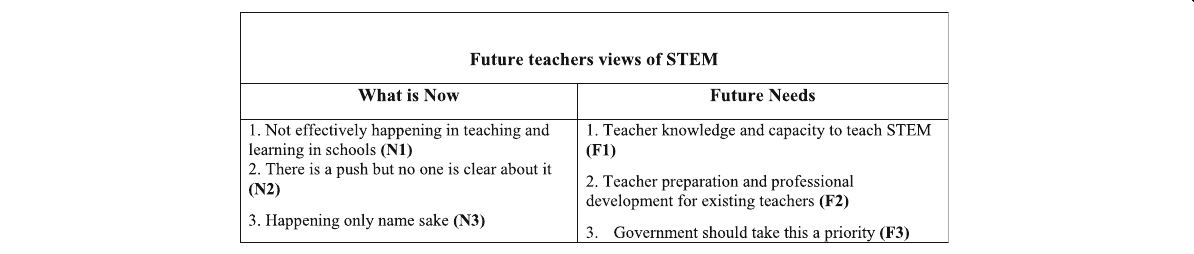
Fig. 5 SEM model of beliefs and intentions towards what is happening now and future